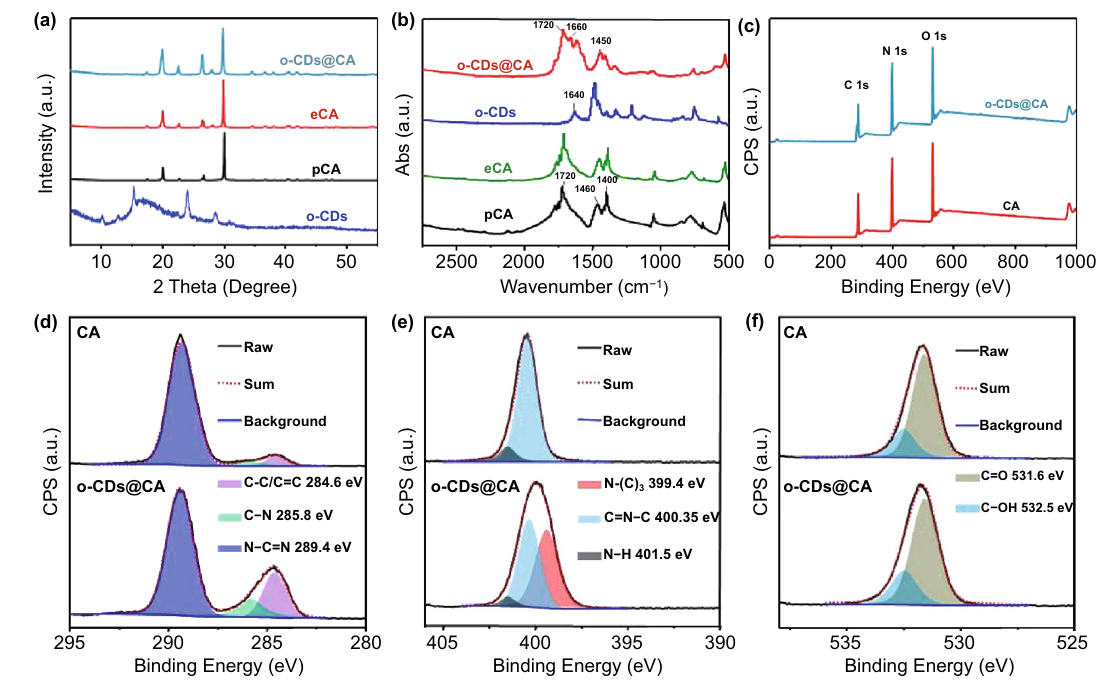
Fig. 2 a‑b XRD patterns and FT-IR spectra of o-CDs, pCA, eCA, and o-CDs@CA ( pCA: pure CA, purchased from the commercial source; eCA: experimental CA, prepared from urea by microwave method); c XPS spectra of CA and o-CDs@CA; d‑f high resolution XPS spectra and the corresponding fitting curves of C 1s d , N 1s e and O 1s f of CA and